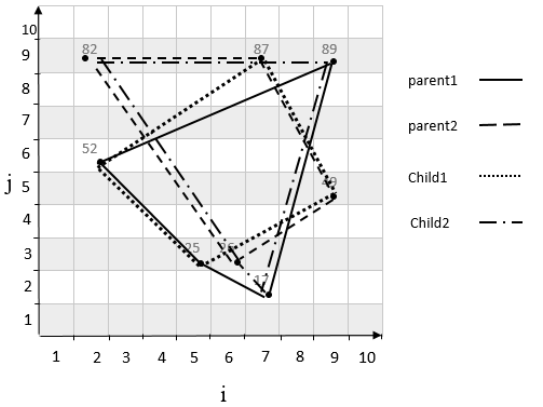
Figure 12. The scope of parent and offspring